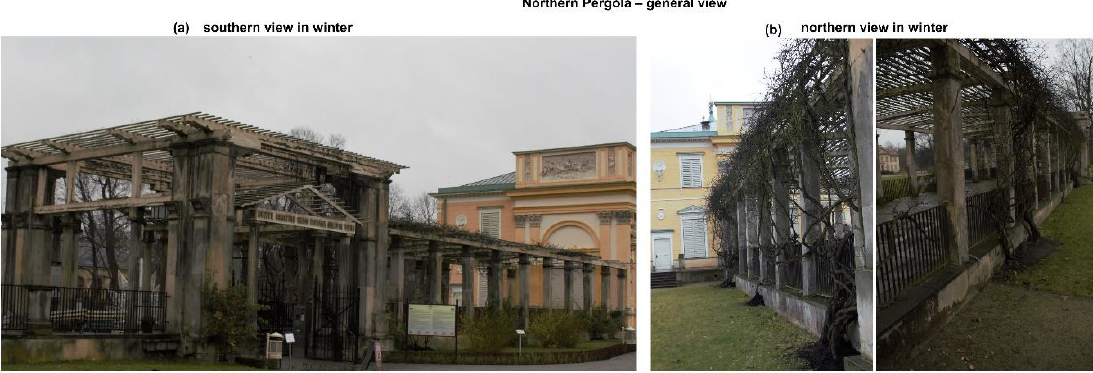
Figure 1. General view of the Northern Pergola in winter from the southern ( a ) and the north-facing side ( b ). Samples that display different biodeterioration patterns (BPs) were taken (except sam- ple no 2) from vertical surfaces and from a similar height from the ground (Figure 2). Ac- cording to the scale used by Caneva et al. [33] both insolation and water availability of the analyzed samples were medium high. Based on these macroscopic examinations, eight different sampling sites from the northern exposition were selected for the diversity anal- yses.